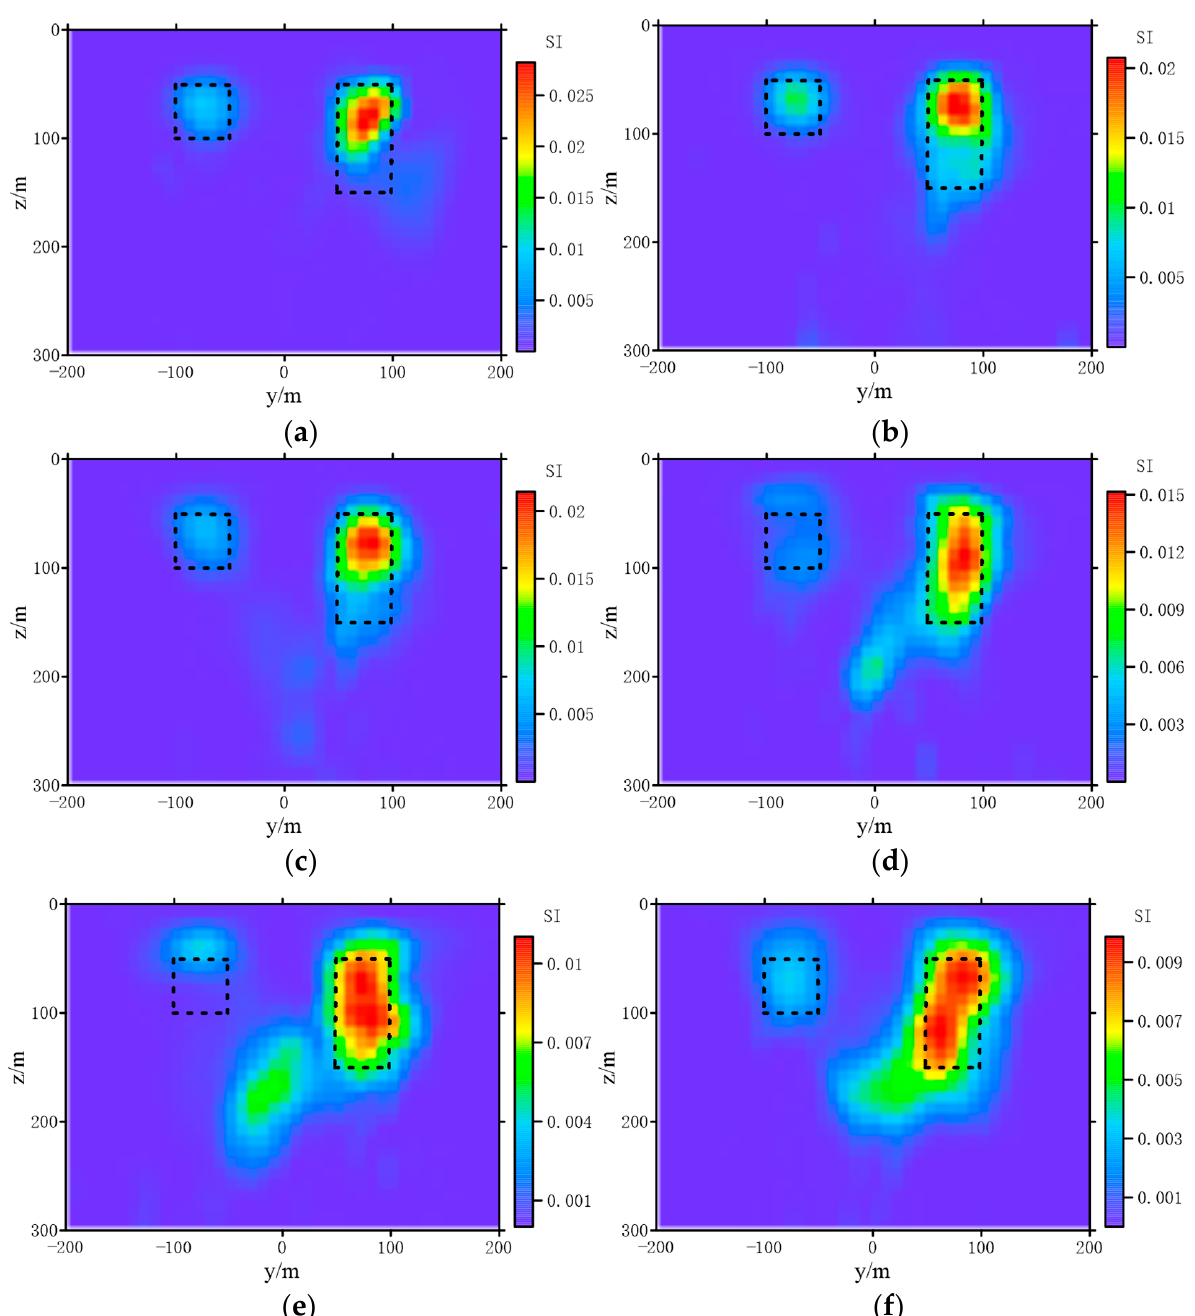
Figure 8. Susceptibility model 3 and its ∆ T field. ( a ) Spatial distribution of magnetic susceptibility of model 3, ( b ) the ∆ T of model 3.